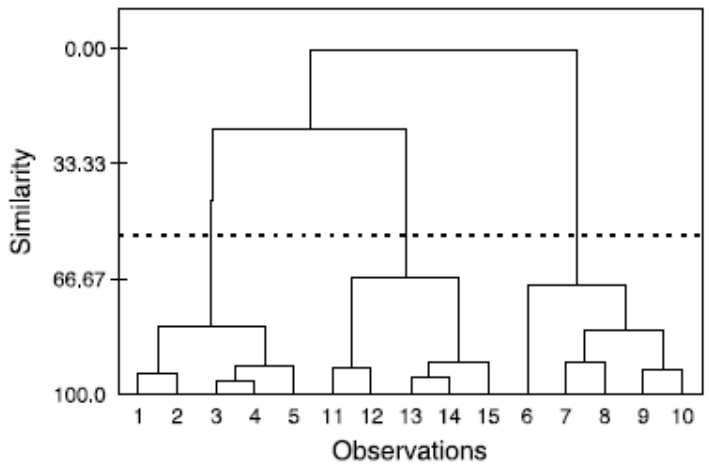
Figure 7. Dendogram illustrating HCA data